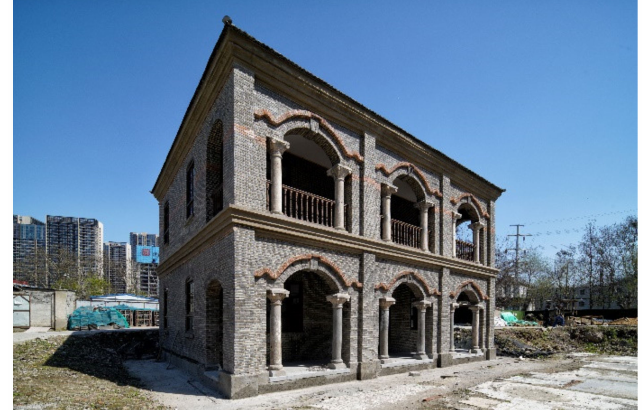
Figure 16. No. 8 Building of “Tianxiangli” (Priest’s